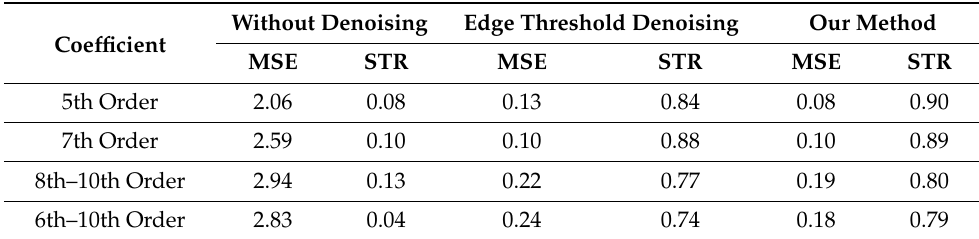
Figure 14. The unwrapping results of noised Zernike aberrations on initial and experimental data. Table 4. MSE and Strehl ratio for each filtering method of Figure 12. Without Denoising Edge Threshold Denoising Our Method Coefficient MSE STR MSE STR MSE